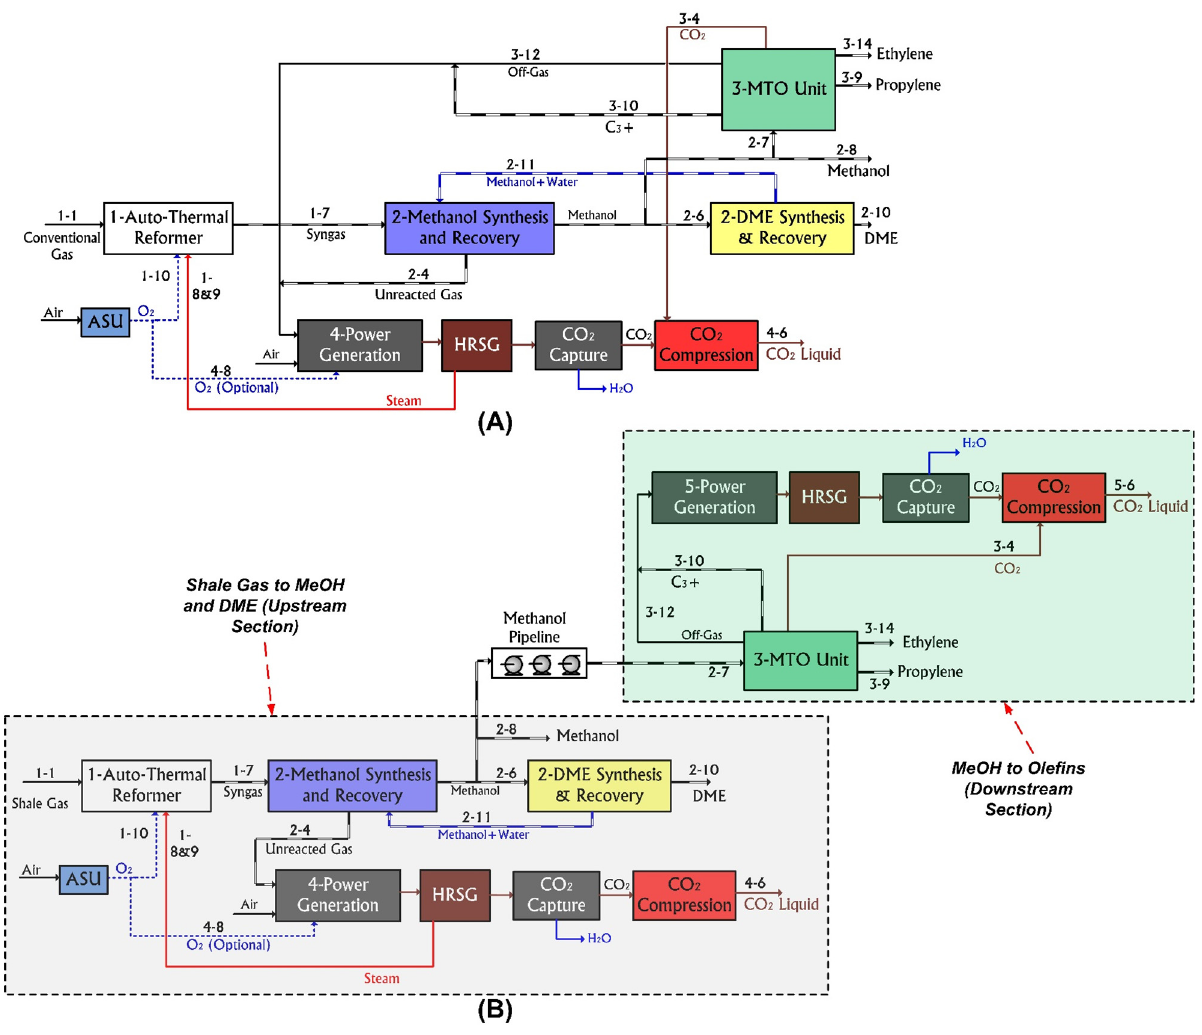
Figure 1. Scheme of the proposed polygeneration process: ( A ) Integrated plant. ( B ) Upstream/downstream